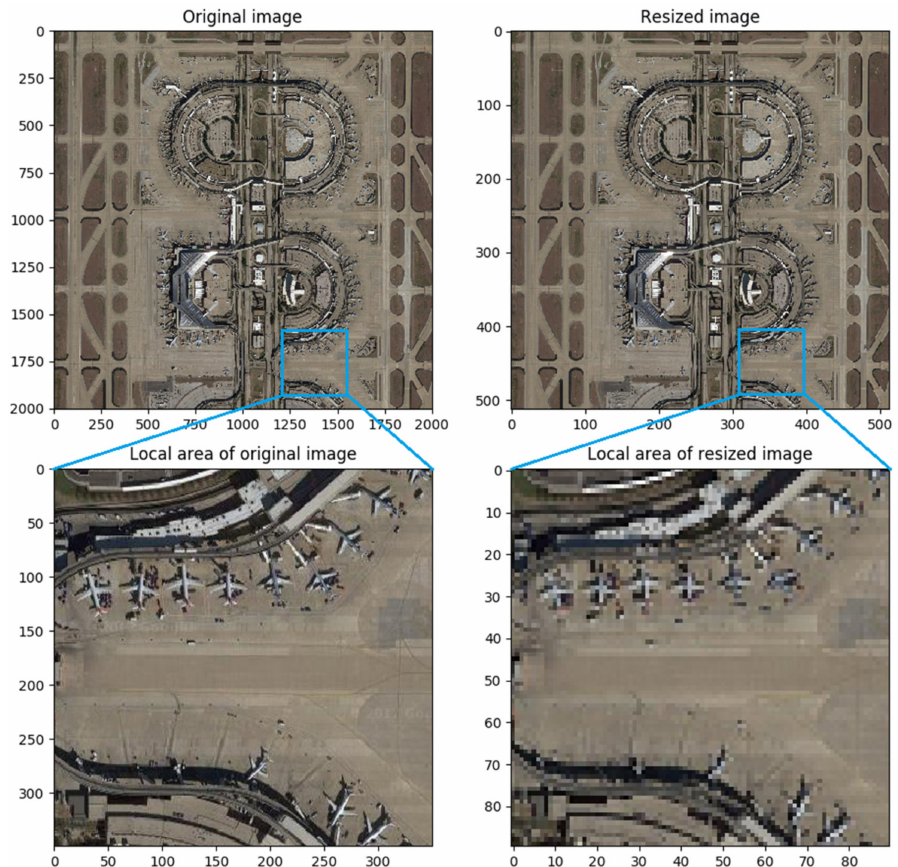
Figure 6. Resizing the original image with a large size. The part marked with the blue box in the figure is enlarged and displayed below it. It can be seen that the resolution of the image is reduced. Since the image is resized directly, the object contour is blurred, which will reduce detection